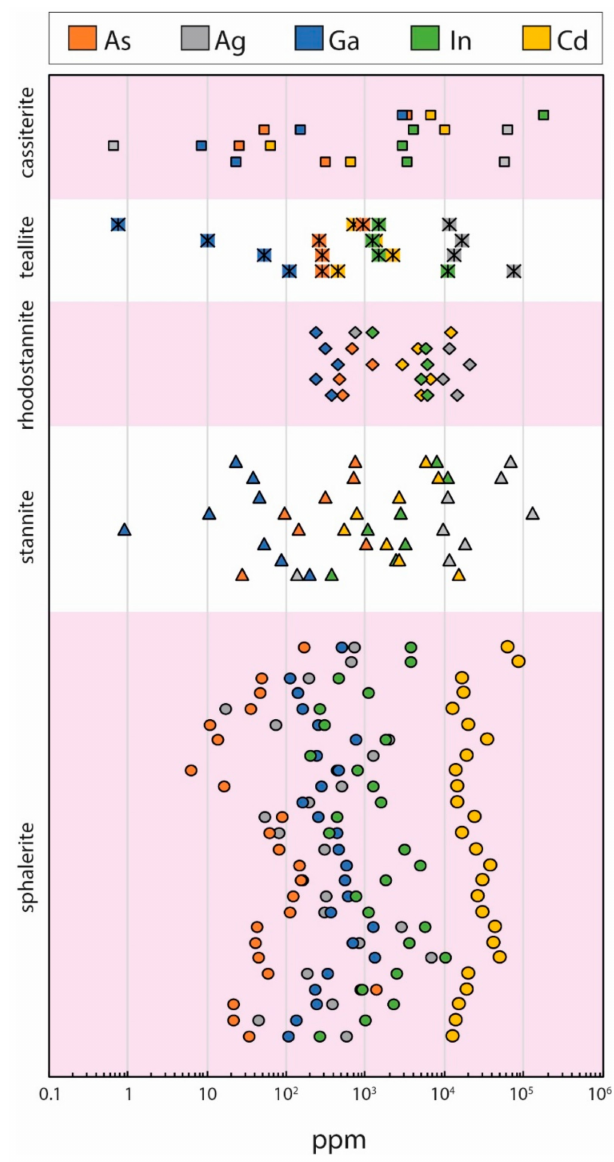
Figure 11. As, Ag, Ga, Sn, In and Cd contents in key minerals cassiterite, teallite, rhodostannite, stannite and sphalerite of the Poop ó deposit as per LA-ICP-MS determinations. See data for critical elements In and Ga in Table 1 and for all elements in Table